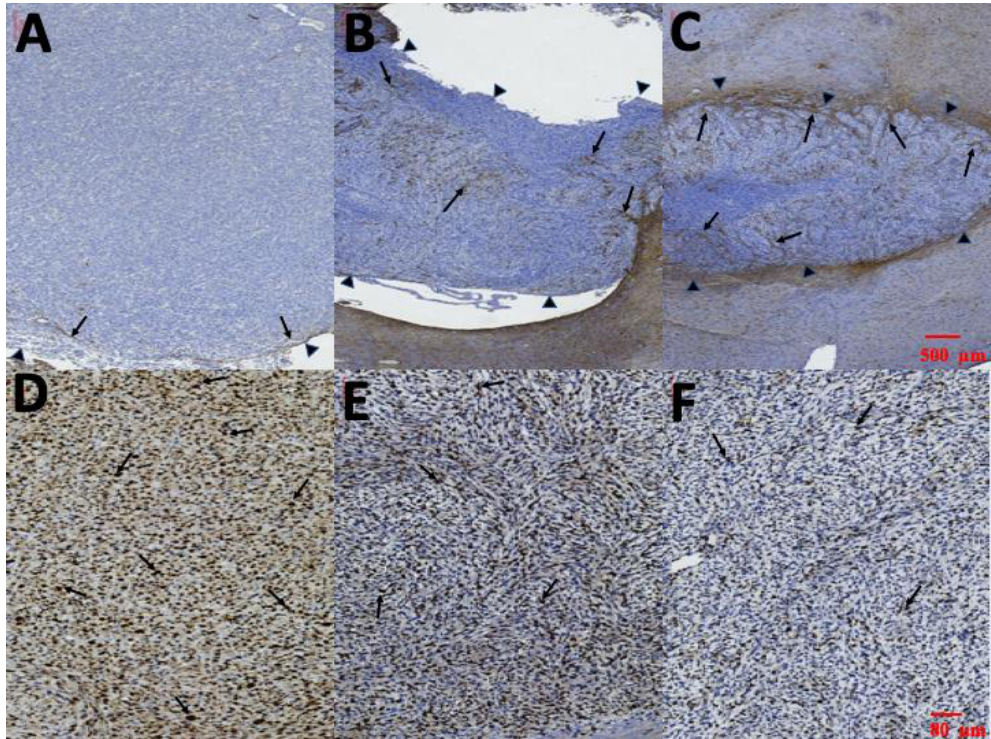
Figure 11. Glial fibrillary acidic protein (GFAP) and Ki-67. ( A )–( C ) Immunohistochemical staining of cytoplasmic processes for GFAP. Almost no intratumoral GFAP-positive cells were detected in group A; several thin GFAP-positive cells were found at the edge of the tumor in group B; and thick GFAP-positive cells with dendrites were noted intratumorally in group C (the tumor edges were indicated by small black triangles and the GFAP-positive cell were indicated by black arrows). ( D )–( F ) Ki-67 labeling index in each group; Ki-67 index in group A: 85.35% ± 9.21%; in group B: 63.35% ± 10.14%; and in group C: 29.56% ± 7.43%. (Ki-67 positive cells were indicated by black arrows.).